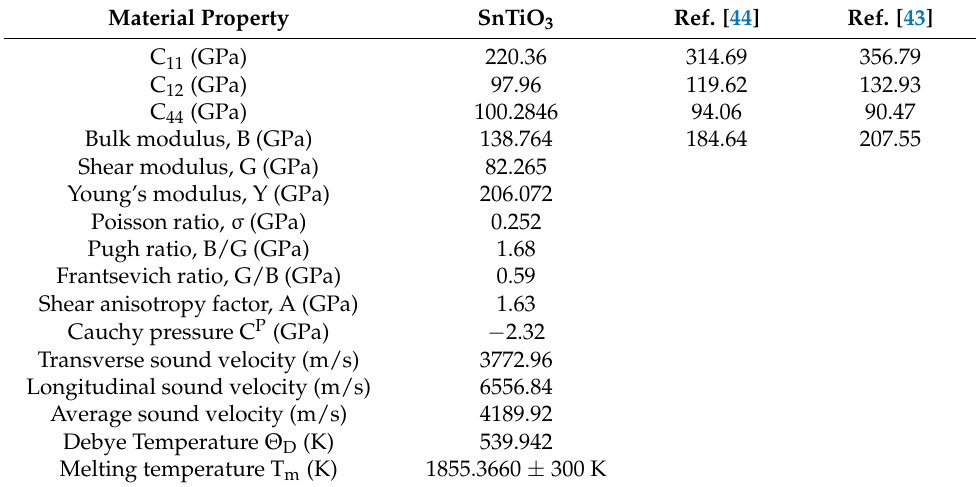
Table 2. Calculated elastic constants C 11 , C 12 , C 44 (in GPa); Bulk modulus B (in GPa); shear modulus G (in GPa); Young’s modulus E (in GPa); Poisson’s ratio ( σ ); B/G ratio; Cauchy pressure; Zener anisotropy factor (A); Debye temperature ( Θ D ) in K; transverse velocity (v t ); longitudinal velocity (v l ); and average velocity (v avg ) in m/s and melting temperature Tm (K) for SnTiO 3